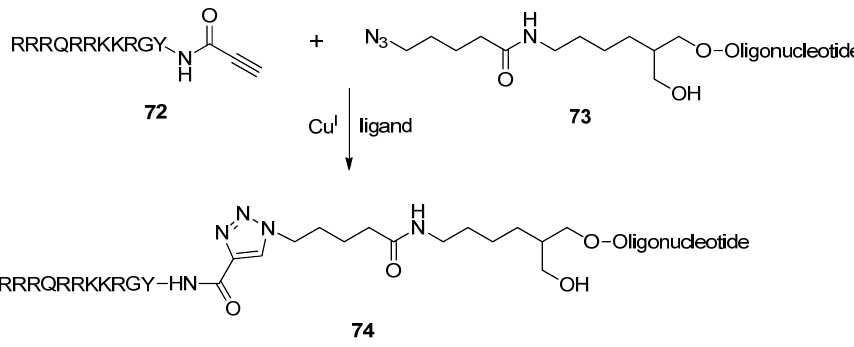
Scheme 14. Synthesis of oligonucleotide-Tat peptide